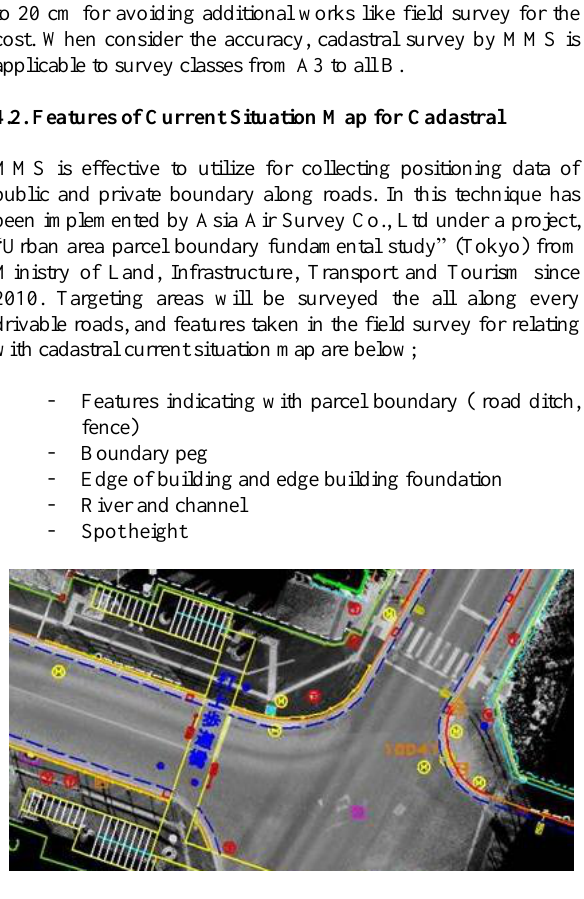
Figure 8. Current situation map with MMS